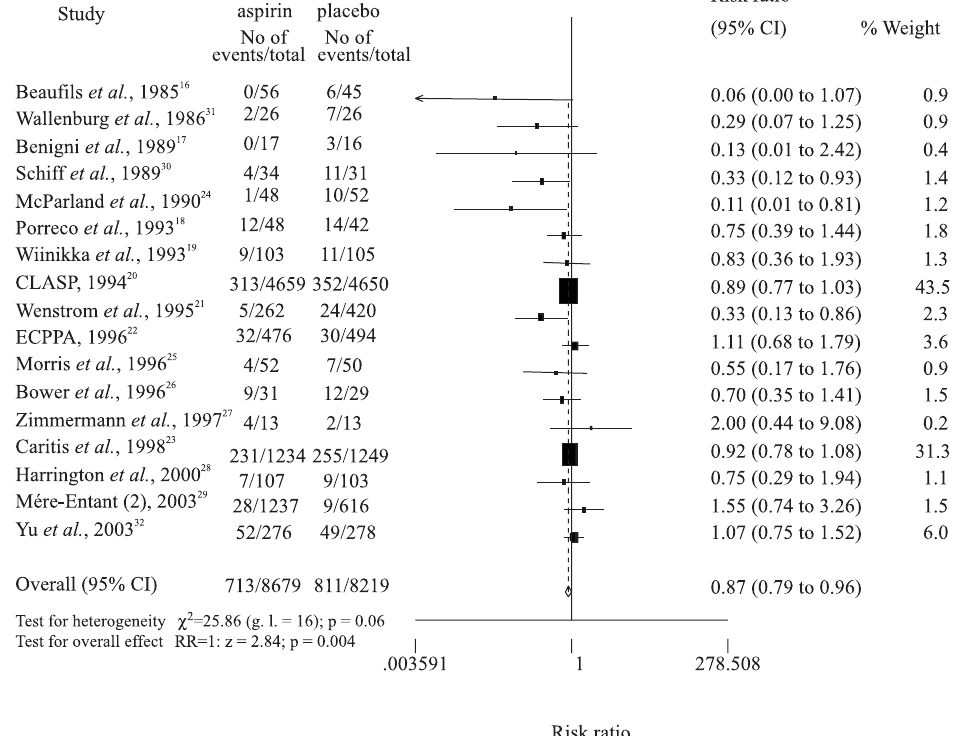
Figure 2 - Effect of low-dose aspirin in the expected outcome in women at high risk for